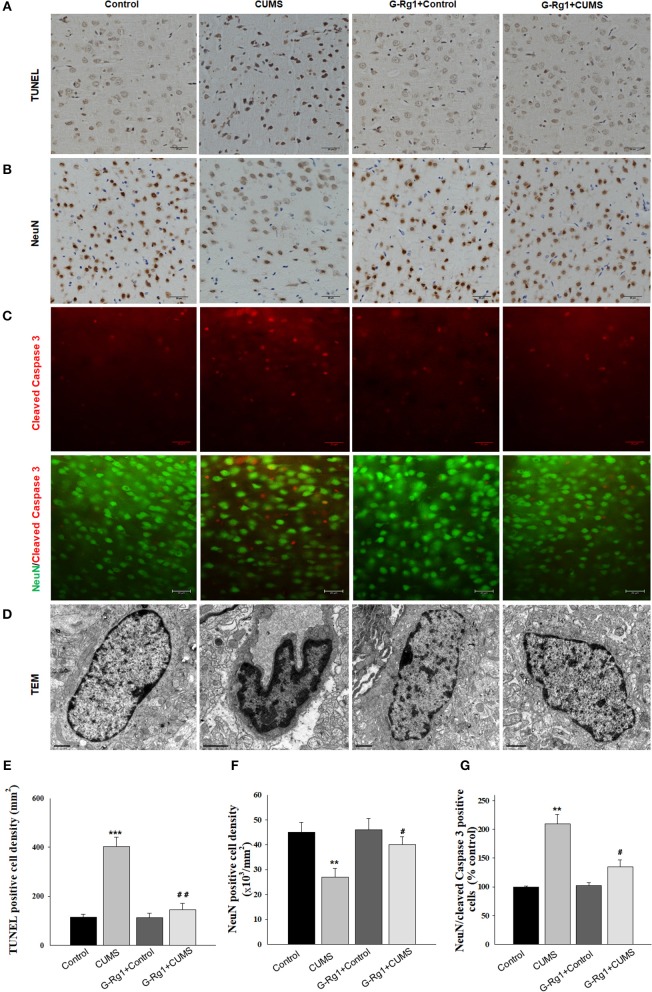
Ginsenoside-Rg1 reduced neuronal apoptosis within the vmPFC region as induced by CUMS-exposure. (A) Representative images of TUNEL staining from the vmPFC region. Scale bar is 20 μm. N = 4 per group. (B) Representative images of immunohistochemical staining of NeuN expression within the vmPFC region. Scale bar is 20 μm. N = 4 per group. (C) Representative images of immunofluorescence staining of NeuN/cleaved Caspase 3 double labeled positive cells within the vmPFC region. Scale bar is 20 μm. N = 4 per group. (D) Representative electron micrograph of vmPFC neuronal ultrastructure revealing nuclear chromatin aggregation, condensation and margination. Scale bar is 1 μm. (E) Bar graphs show quantification of TUNEL positive cells density in the vmPFC region. (F) Bar graphs show quantification of NeuN positive cells density in the vmPFC region. (G) Bar graphs show quantification of NeuN/cleaved Caspase 3 positive cells in the vmPFC region. N = 6 per group. Data were presented as the means ± SEM. **P < 0.01, ***P < 0.001 CUMS vs. Control group; #P < 0.05, ##P < 0.01 G-Rg1+CUMS vs. CUMS group. G-Rg1, Ginsenoside-Rg1.